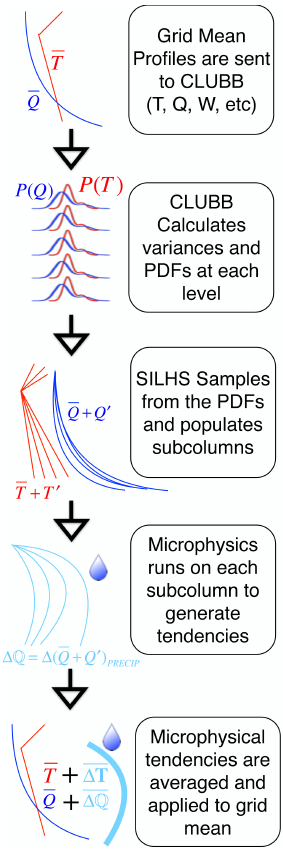
Figure 1. The sequence of calculations in CAM-CLUBB–SILHS. Red lines represent temperature profiles and dark blue lines rep- resent moisture profiles, as an example. Light blue lines represent figurative microphysical tendencies, for both temperature and mois- ture. For details on the SILHS and subcolumn methodology, see Sect.